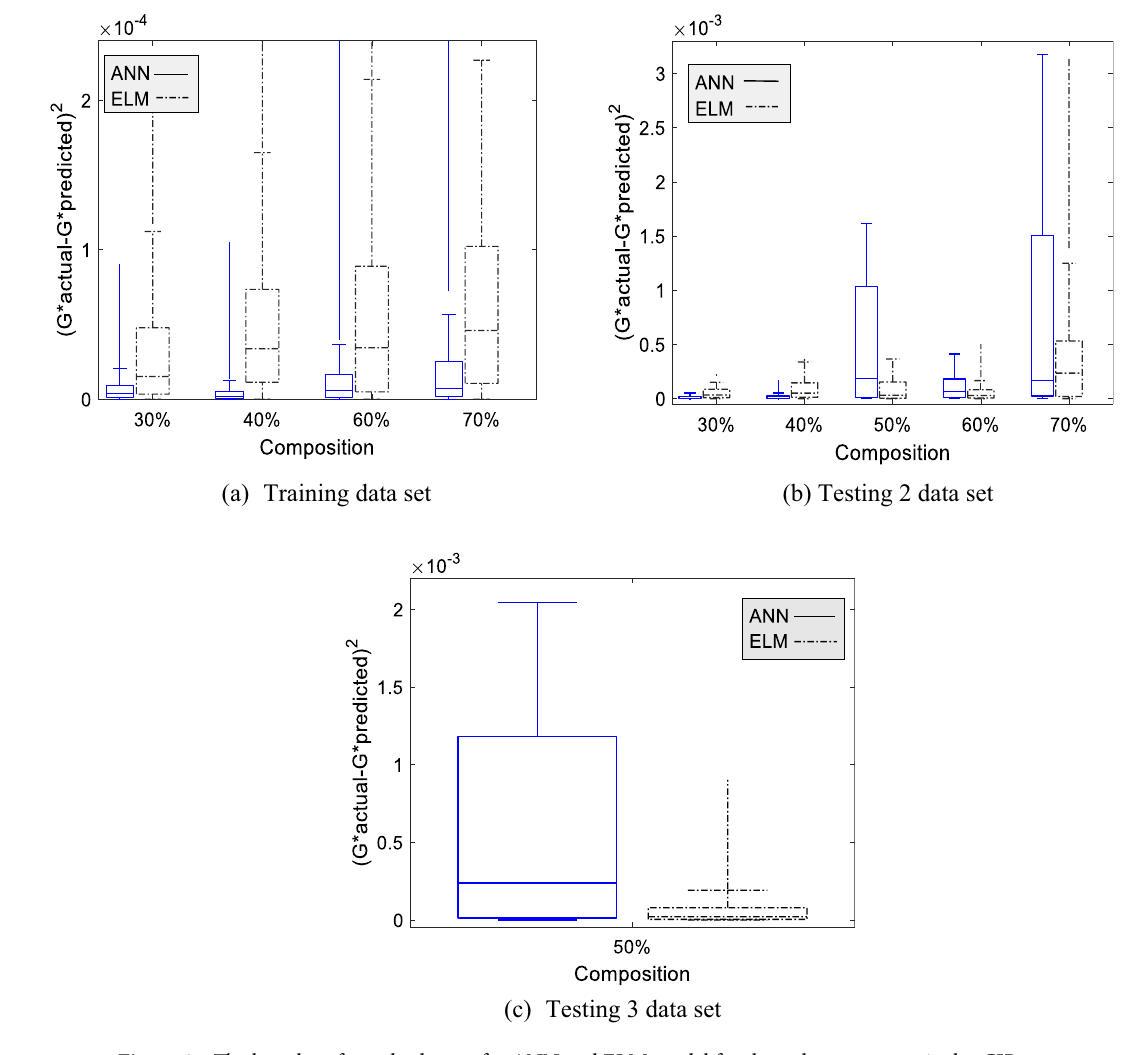
Figure 8. The boxplot of standard error for ANN and ELM model for three data set at particular CIP